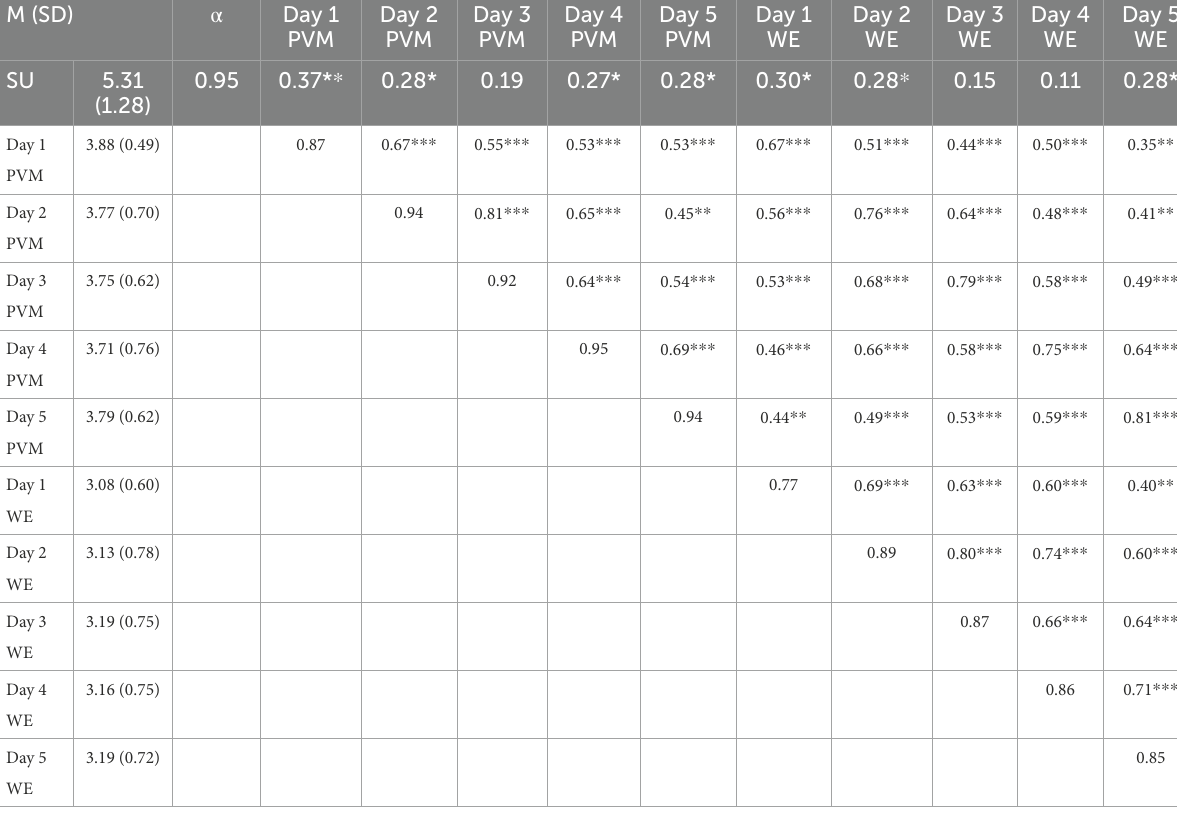
TABLE 2 Descriptive statistics, scale reliabilities, and bivariate correlations among daily PVM, WE, and general